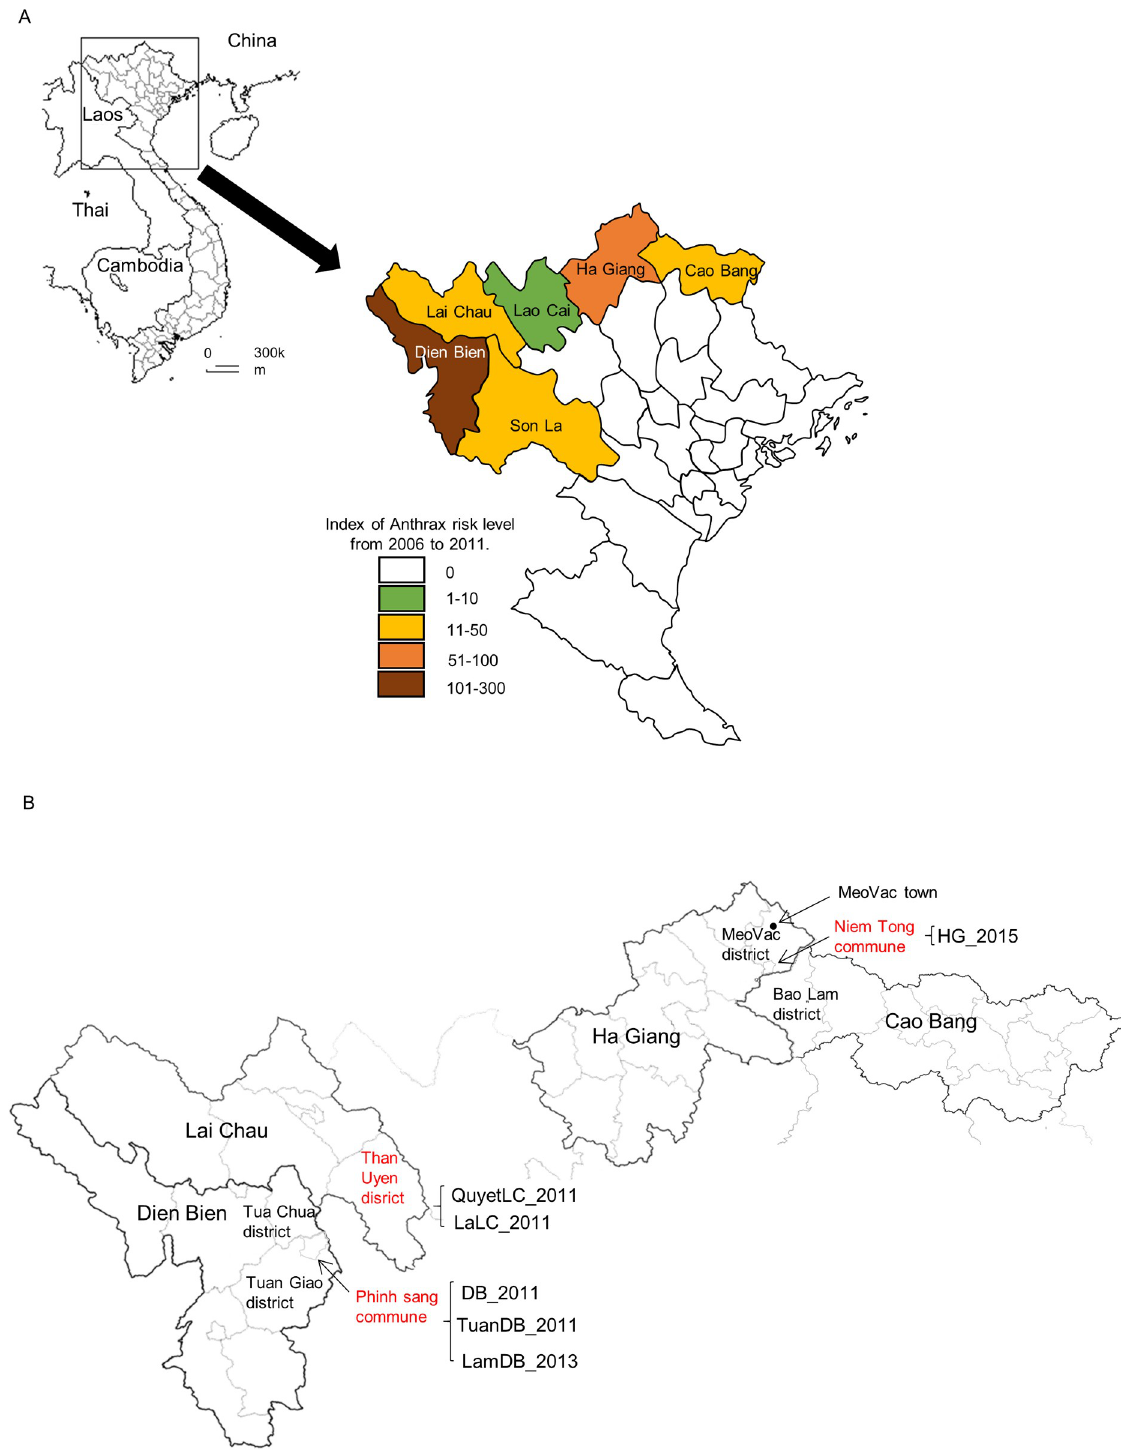
Fig 1. Epidemiological and geographical information about Vietnamese anthrax. (A) Map of Vietnam showing the distribution of human anthrax in northern provinces from 2006 to 2011. The color indicates the human anthrax risk level depending on the number of human anthrax cases occurring from 2006 to 2011 [5]. (B) The anthrax hotspot commune and district are shown. The isolation sites of strains used in the present study are indicated in red, from Dien Bien, Lai Chaˆu, and Ha Giang provinces in northern Vietnam.